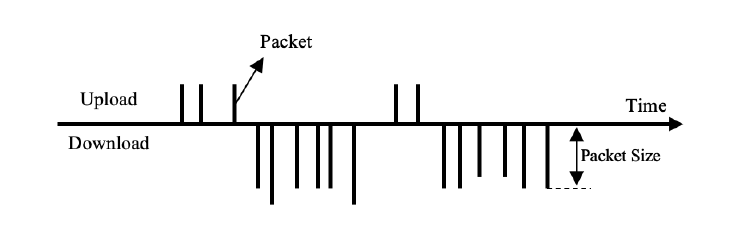
Figure 1. Flow model-based packet.